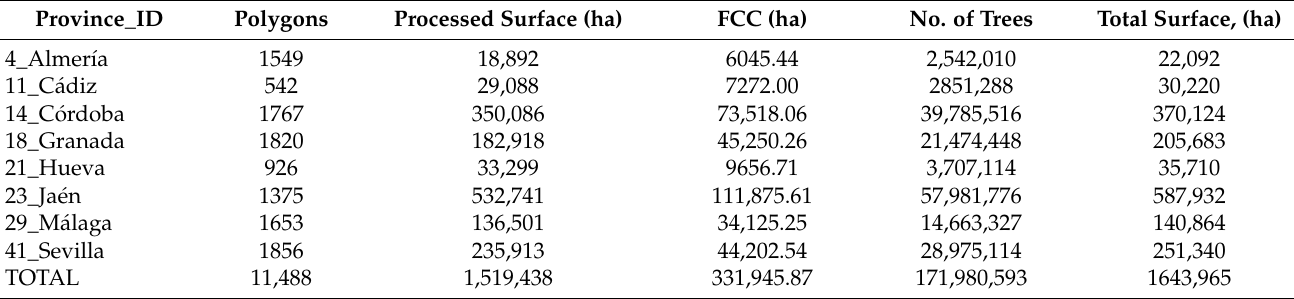
Table 3. Summary of the characterized olive grove